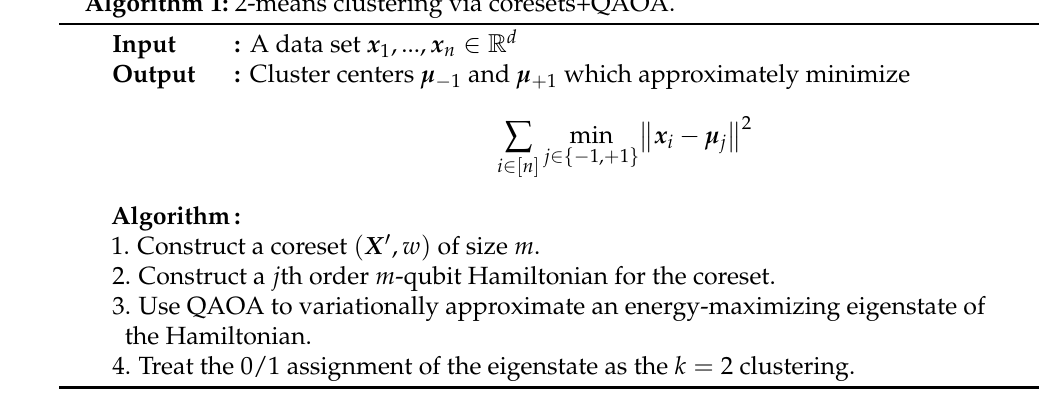
Algorithm 1: 2-means clustering via